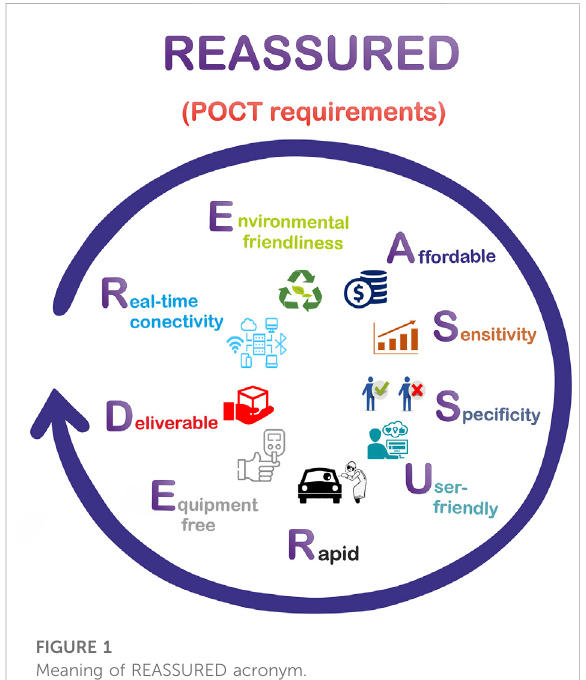
FIGURE 1 Meaning of REASSURED